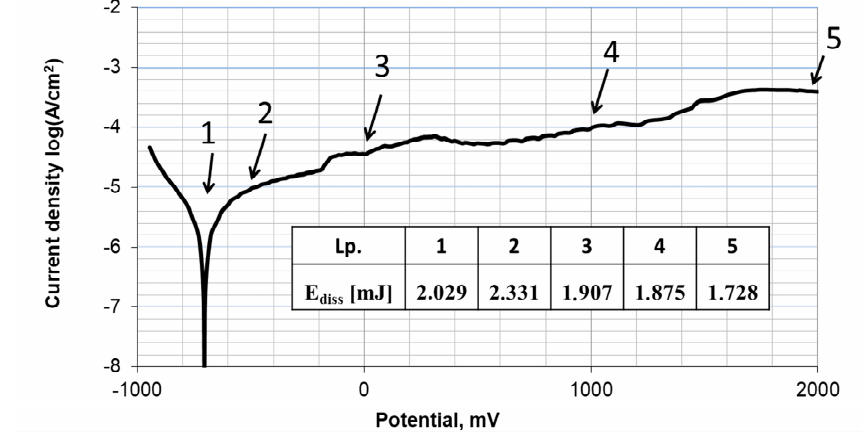
Figure 13. Energy dissipation during fretting corrosion (p = 15 MPa) in artificial saliva (B).